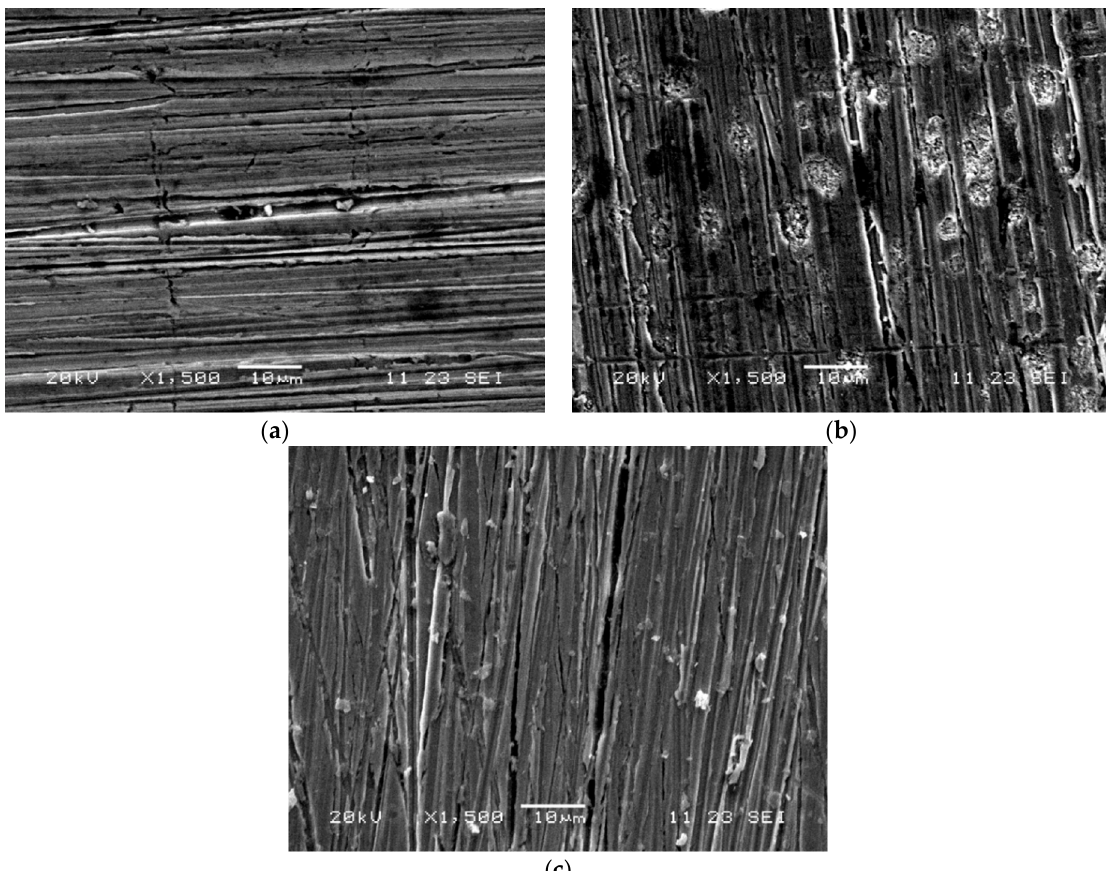
Figure 3. SEM micrographs of α -brass surface ( a ) before polarization, ( b ) after polarization in borate bu ff er (pH 7.4) + 10 mM NaCl, ( c ) after polarization in borate bu ff er (pH 7.4) + 10 mM NaCl + 1.00 mM of 3-mercapto(3-methylbutyl)-5-amino-1 H -1,2,4-triazole (structure B). Table 4. Elemental surface composition (at. %) of the brass